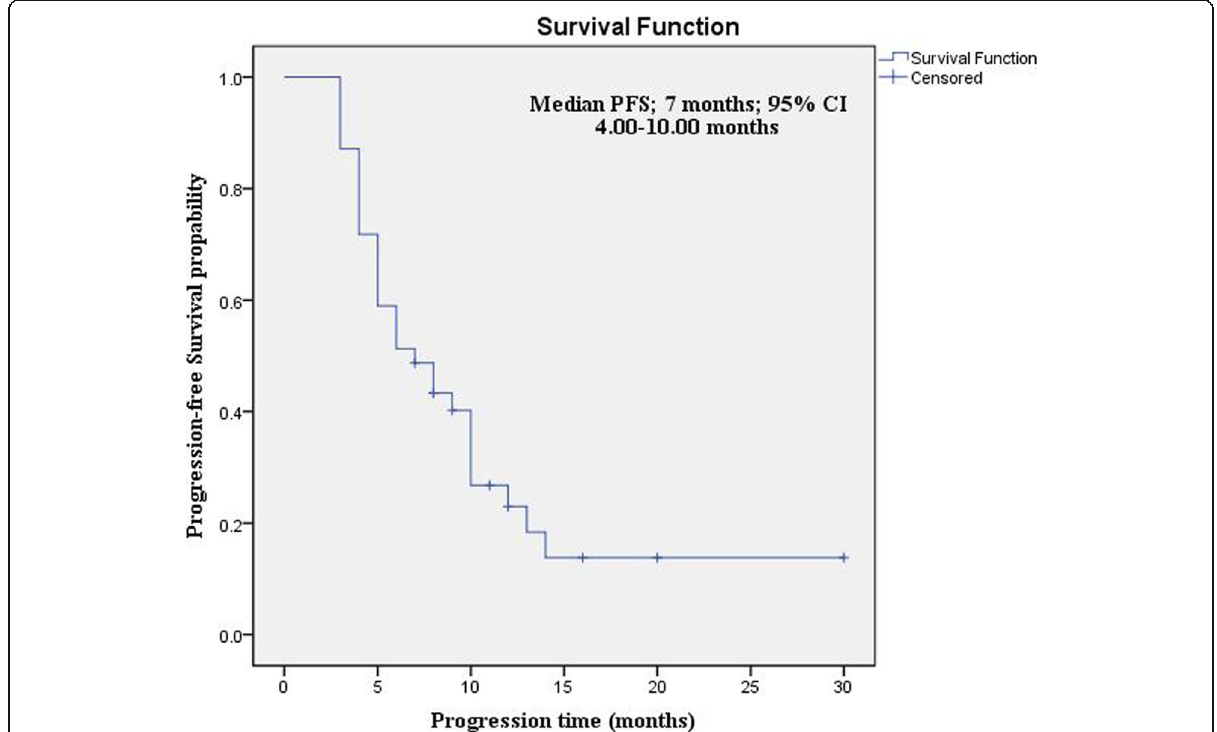
Fig. 2 Kaplan-Meier plot: progression-free survival. CI confidence interval, PFS progression-free survival